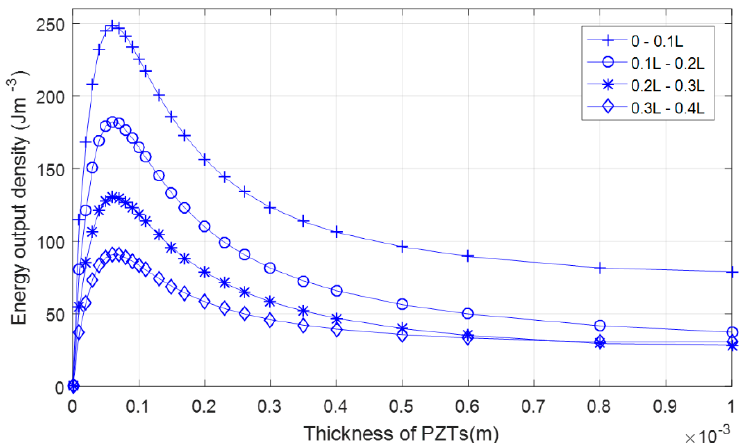
Figure 7. Energy output density with thickness under different locations of wing span ( L ) at the leading edge symmetric PZTs layers from wing